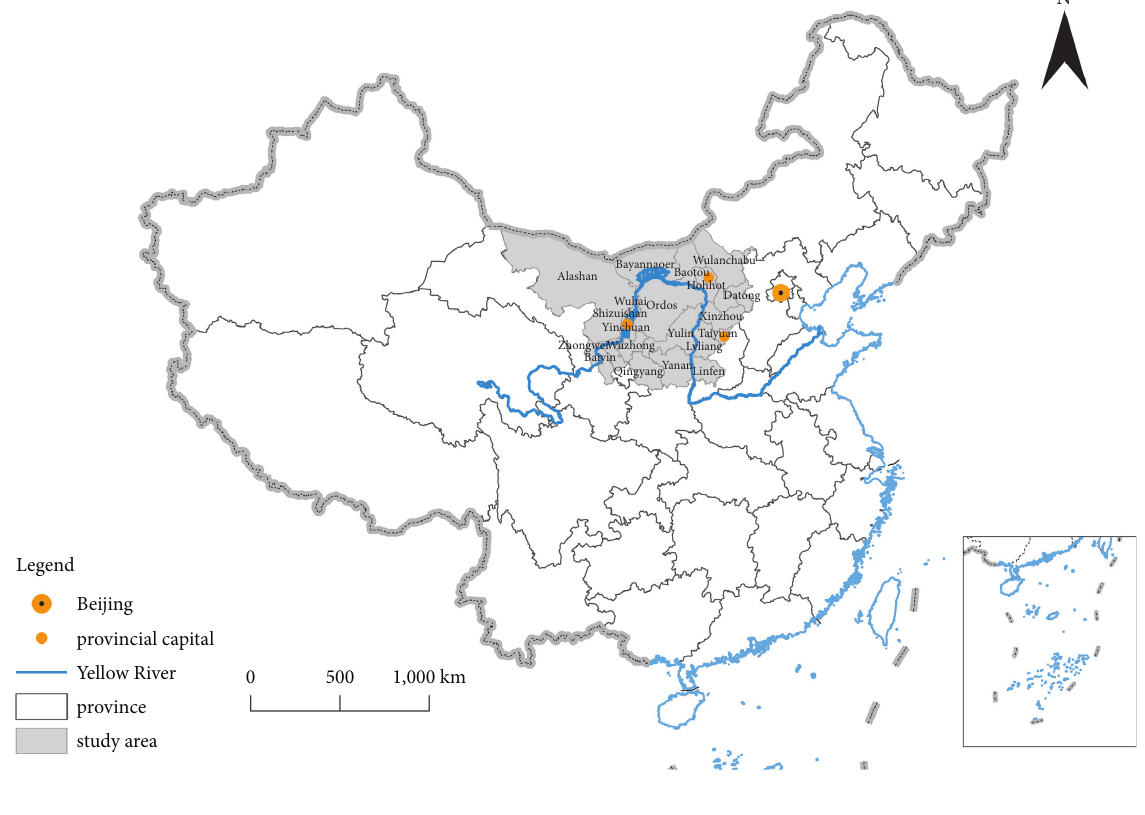
Figure 1: The study